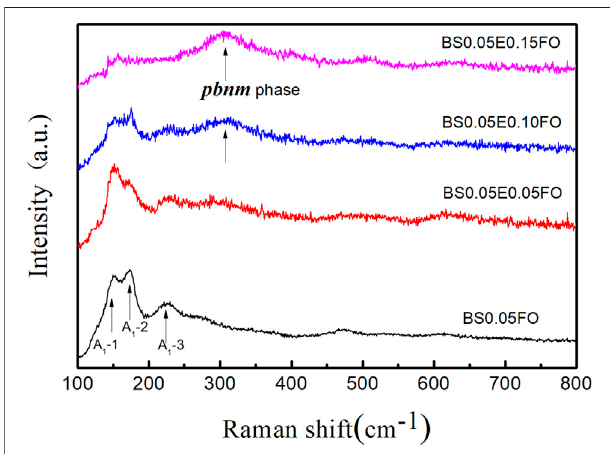
FIGURE 2 | Raman spectra as a function of Eu composition.